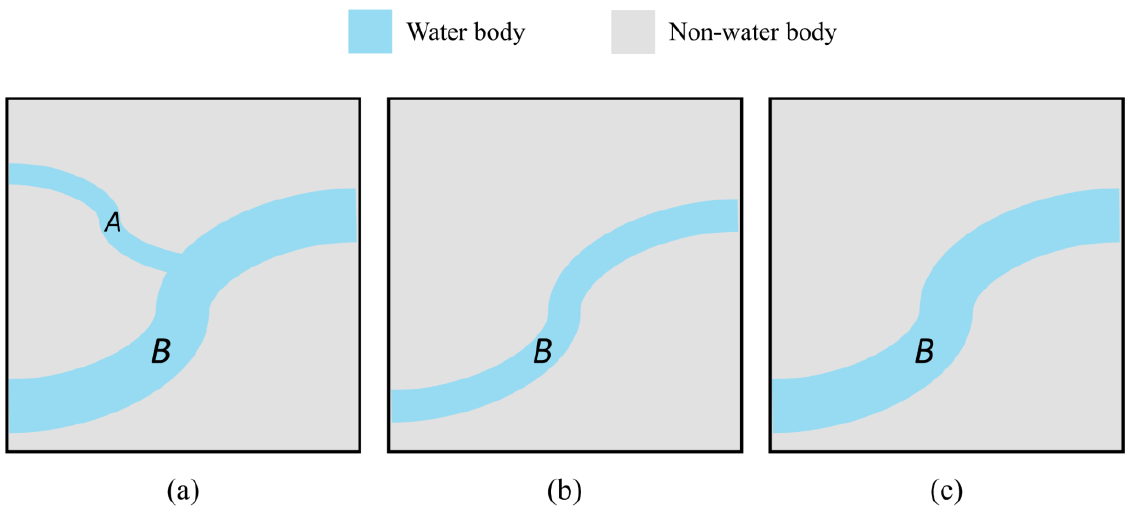
Figure 2. Illustration of the principle of extracting water bodies: ( a ) original; ( b ) after the 1st buffering; ( c ) after the 2nd buffering. The proposed approach has two main